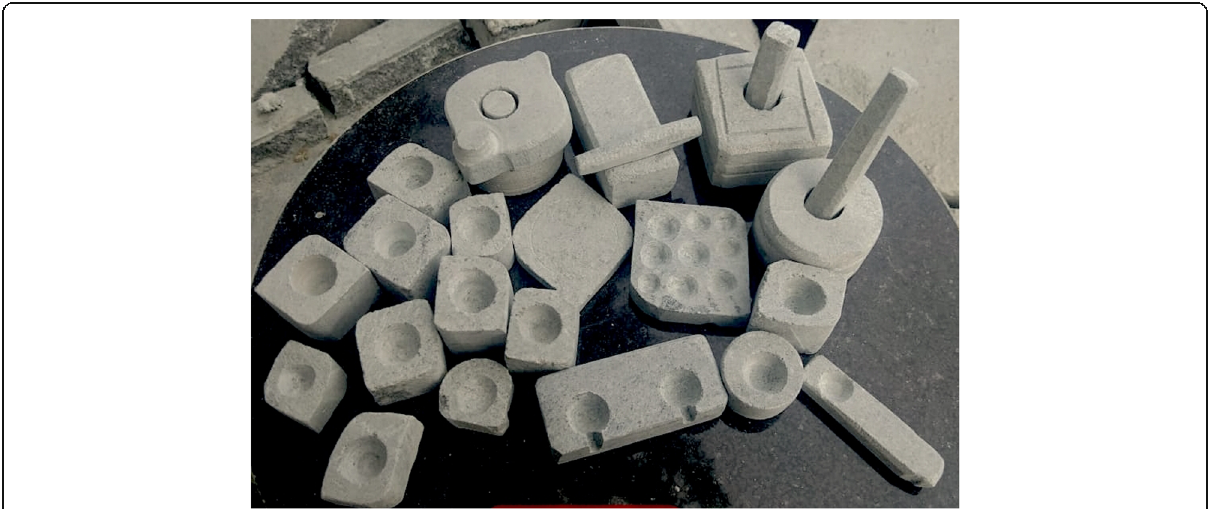
Fig. 2 The soapstone made soppu saman , a miniature kitchen utensil toy set for